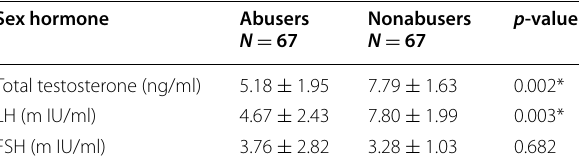
Table 7 The means of sex hormones among studied abusers compared to nonabusers